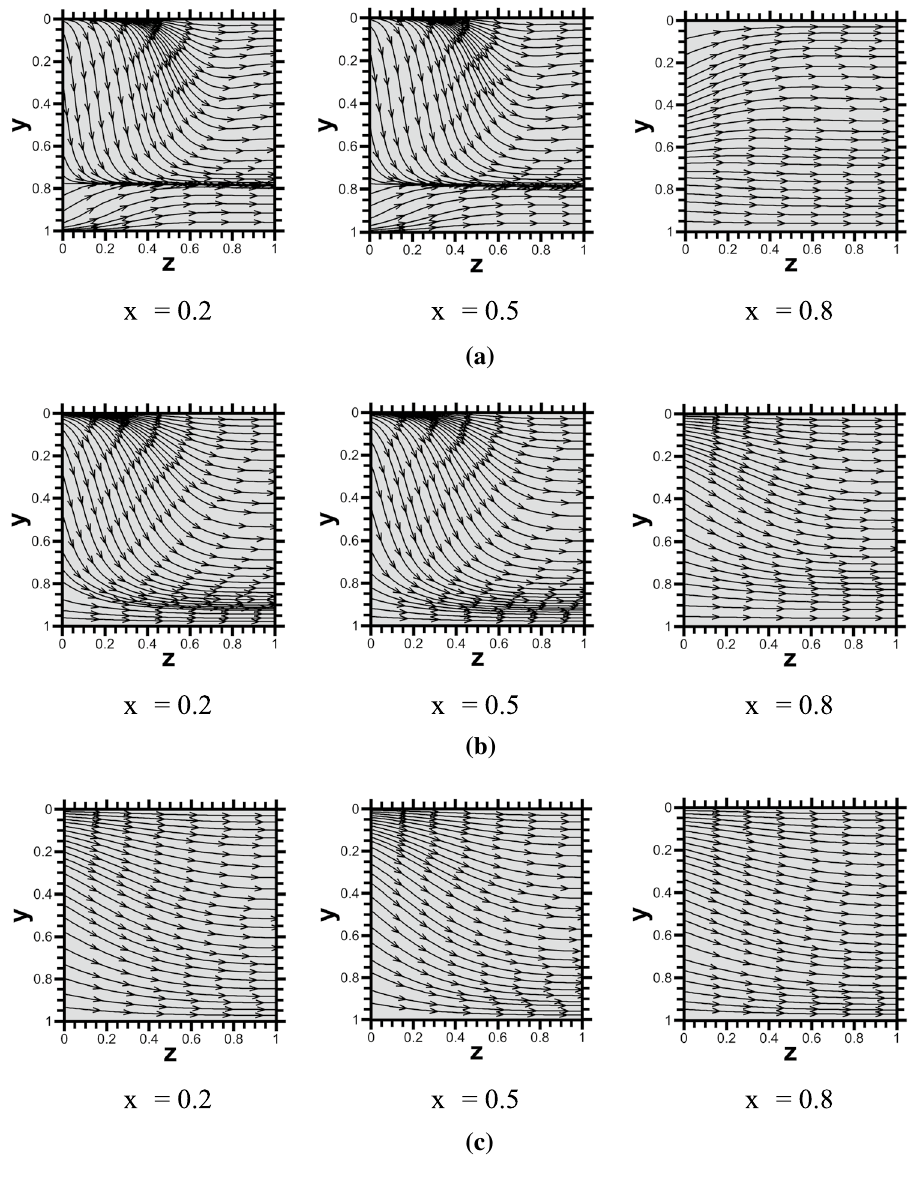
Fig. 17 A sample of the stream lines in the transverse section for passing plates through the 𝜐 length ( = 0.25) a t = 0.05, b t = 0.1, c t =